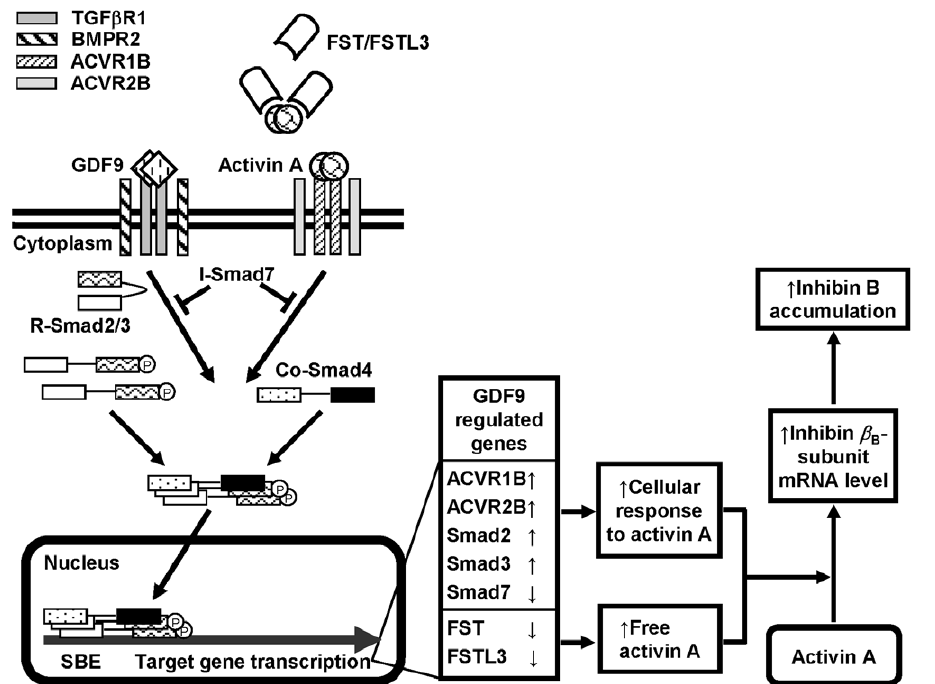
Figure 6. A model on the interactions between GDF9, activin A, and FST/FSTL3 in regulating inhibin B production. GDF9 increases hGL cell response to activin A by acting on GDF9 receptors, BMPR2/TGF b R1, which then activate Smad2/3 to form complexes with Smad4. These complexes then activate transcription factors in the nucleus to target genes that increase ACVR2B/1B and Smad2/3 expression and reduce Smad7 activity [16,17]. These changes, in turn, allow more activin A to bind to its receptors and increase the cellular response to accumulate inhibin b B - subunit, and corresponding inhibin B intracellularly. Additionally, GDF9 inhibits FST and FSTL3 gene transcription and FST and FSTL3 secretion extracellularly, reducing the amount of FST and FSTL3 binding to activin A which then activates activin receptors and the downstream signaling cascade and increases inhibin B accumulation. Abbreviations: ACVR, activin receptor; BMPR2, bone morphogenetic protein type II receptor; FST, follistatin; FSTL3, follistatin-like 3; GDF9, growth differentiation factor 9; Smad, son of mothers against decapentaplegia; SBE, Smad binding element; Co-Smad, common Smad; I-Smad, inhibitory Smad; R-Smad, receptor-activated Smad; TGF b R1, transforming growth factor b type I receptor.